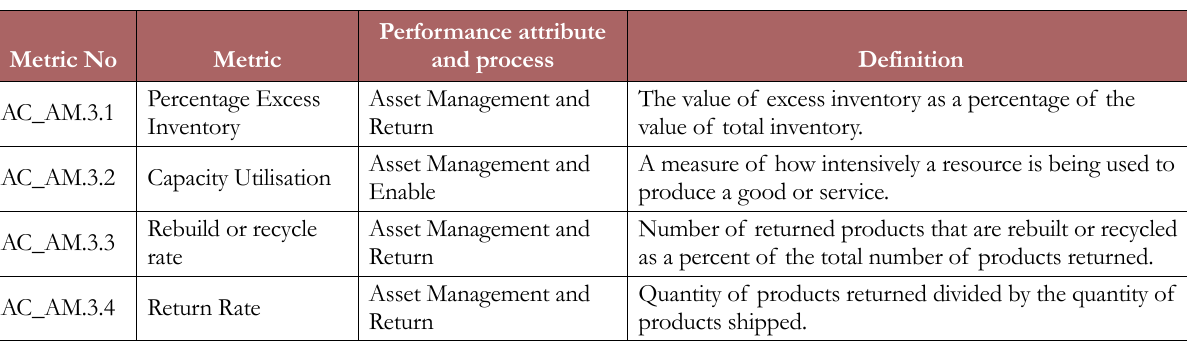
Table 4. Proposed SCOR metrics for the airline catering supply chain. Adapted from SCOR Model Version 12.0 (APICS,